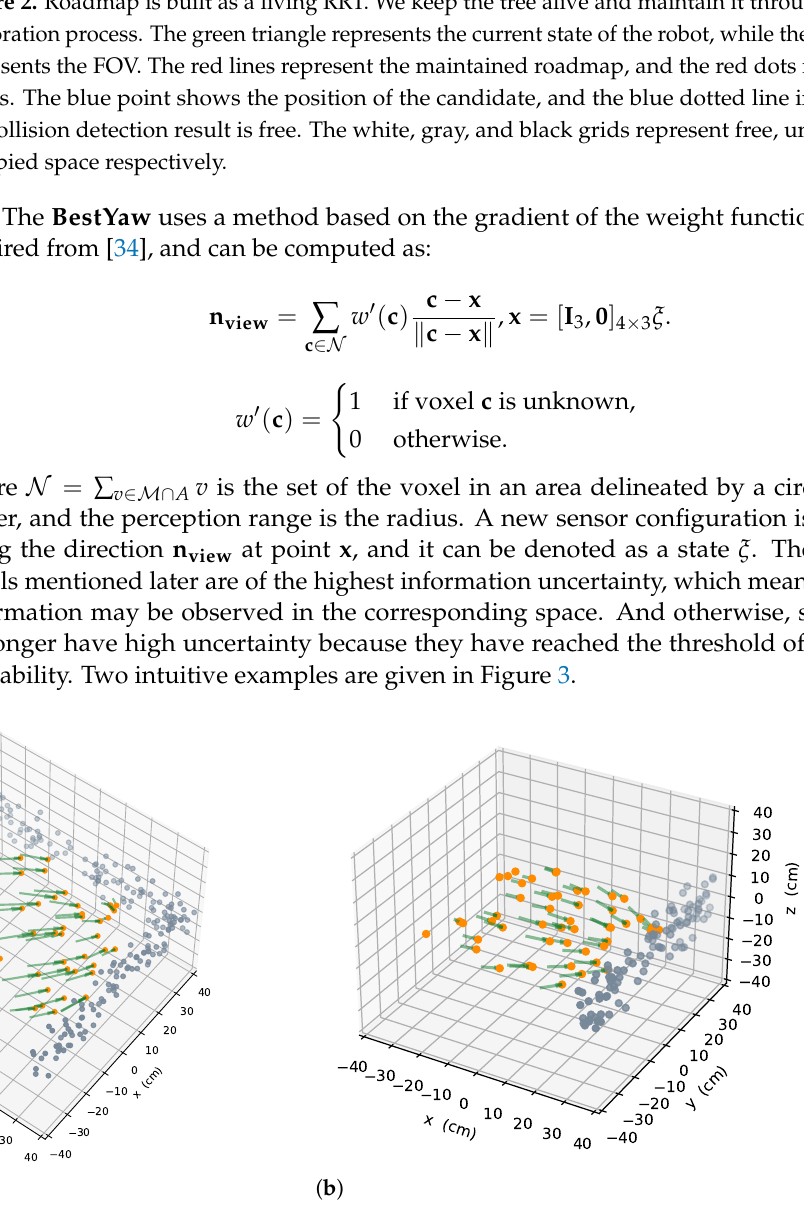
Figure 3. Example of best yaw in two scenarios, each gray point depicts the position of an unknown voxel; a green arrow with an orange dot shows the best scanning direction. ( a ) Scenario one. ( b ) Scenario